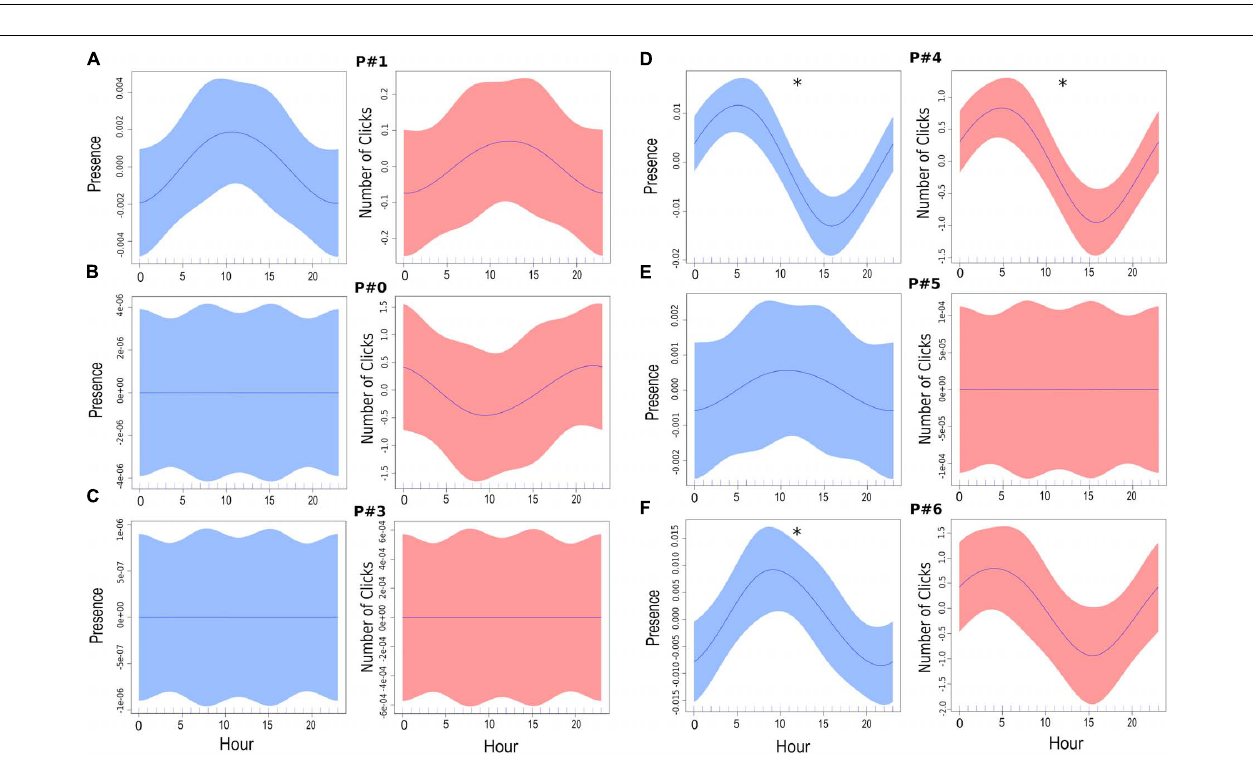
FIGURE 9 | Diel detection probability. (A) Boxplot showing the detection probability in the 4-h clusters selected for all the PAM sites (P#1, P#0, P#3, P#4, P#5, P#6). (B) Stacked bar graph showing the detection probability within the different 4-h clusters for each PAM site.